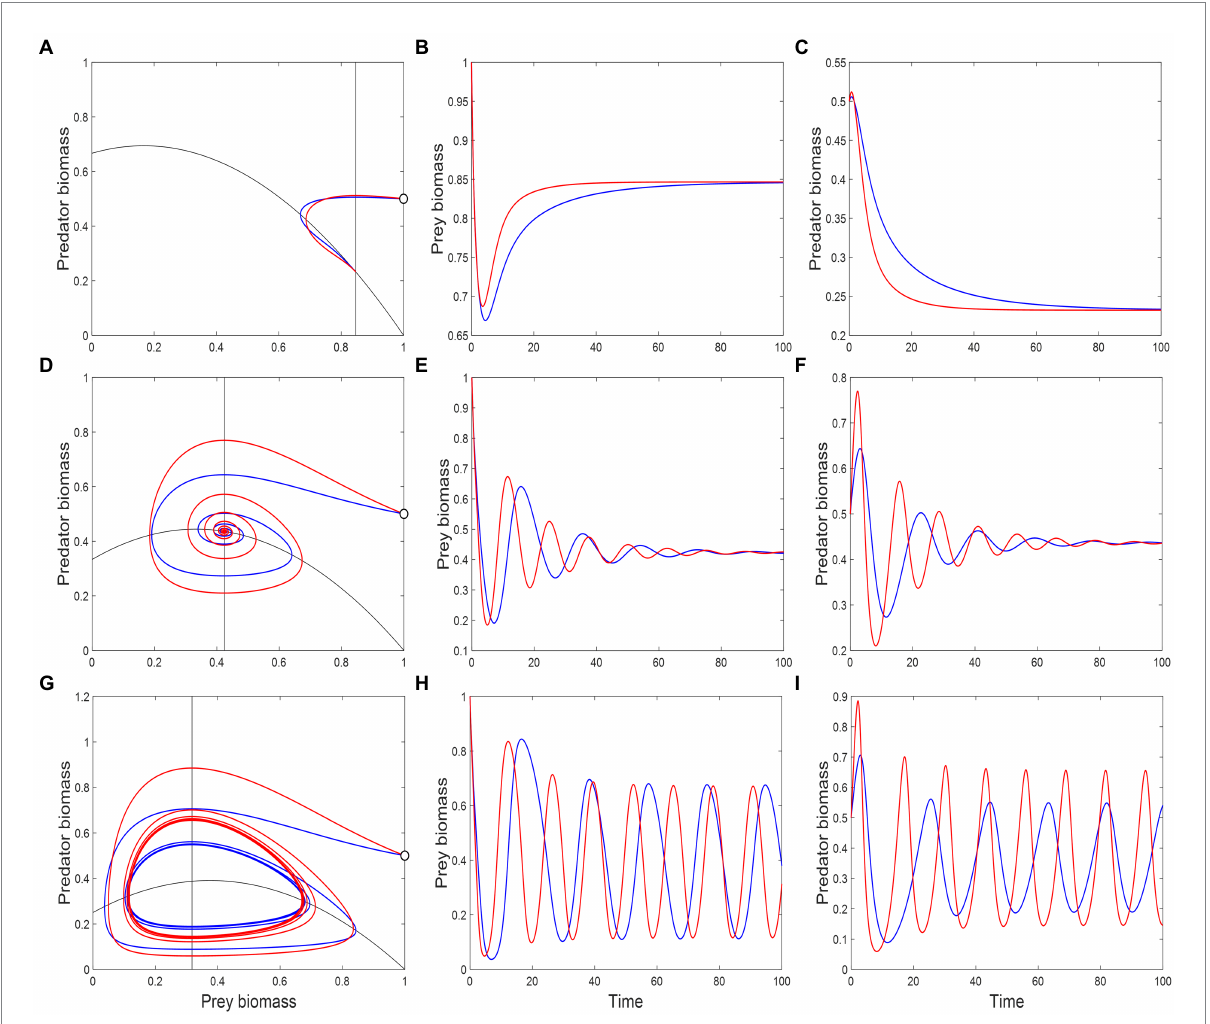
FIGURE 6 Phase-space plots and population trajectories from the modified Rosenzweig–MacArthur model (Equation 6a and 6b). Red and blue lines represent the system dynamics with and without a metabolic response, respectively. Black lines in the phase-space plots (A, D, G) are the predator and prey isoclines